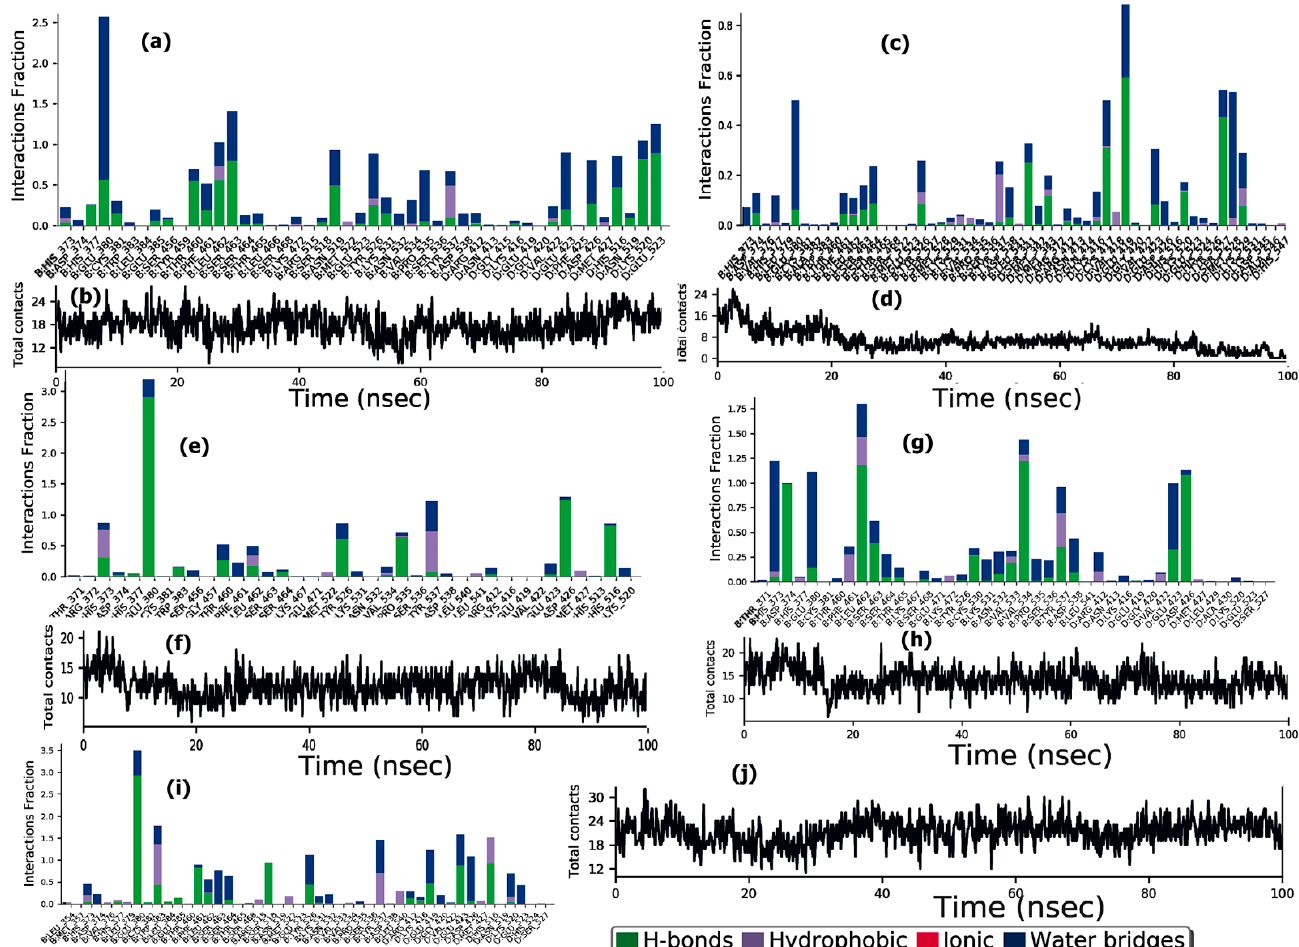
Figure 9. Protein ligand contacts of ER α -ligand complexes ( a ) with Pep; ( b ) total number of contacts during the simulation with Pep; ( c ) with Mut1; ( d ) total contacts during the simulation with Mut1; ( e ) with Mut2; ( f ) total number of contacts during the simulation with Mut2; ( g ) with Mut3 peptide; ( h ) total number of contacts during the simulation with Mut3; ( i ) with Mut4 peptide; ( j ) total number of contacts during the simulation with Mut4.